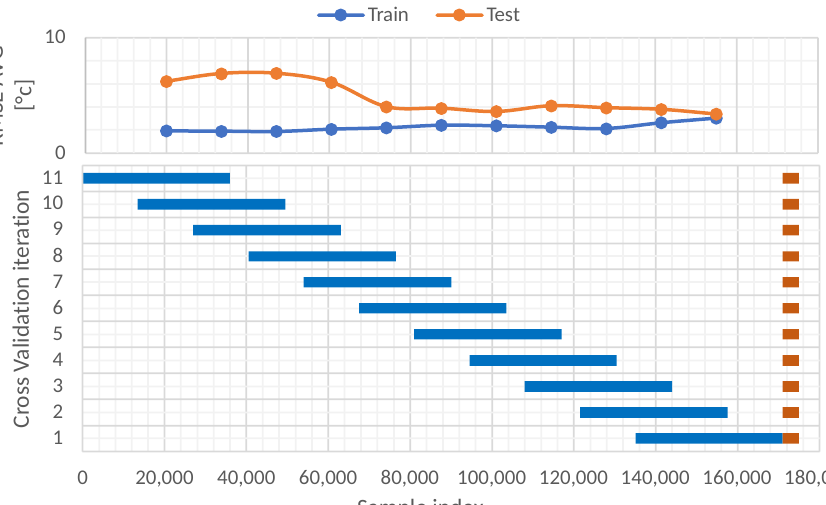
Figure 12. Blocking time series split with static test set cross-validation data